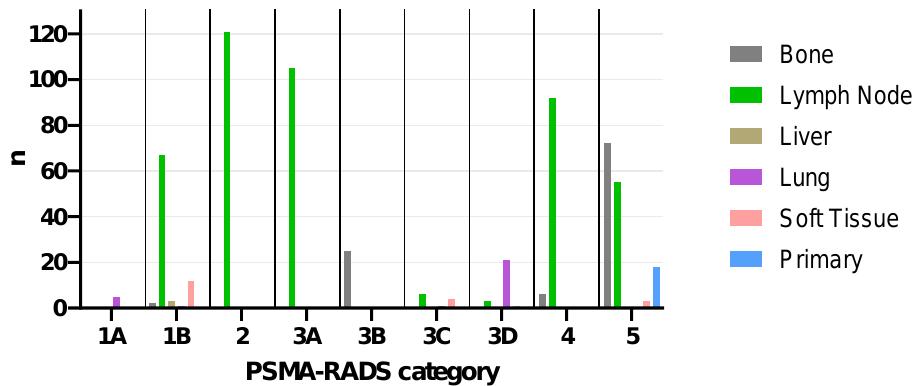
Figure 1. Bar graph showing the distribution of total lesions (n = 623) across all compartments and PSMA-RADS categories. Bone: 1B (n = 2), 3B (n = 25), 4 (n = 6), 5 (n = 72), total (n = 105); Lymph Node: 1B (n = 67), 2 (n = 121), 3A (n = 105), 3C (n = 6), 3D (n = 3), 4 (n = 92), 5 (n = 55), total (n = 449); Liver: 1B (n = 3), total (n = 3); Lung: 1A (n = 5), 1B (n = 1), 3C (n = 1), 3D (n = 21), total (n = 28); Soft Tissue: 1B (n = 12), 3C (n = 4), 3D (n = 1), 5 (n = 3), total (n = 20); Primary: 5 (n = 18), total (n = 18). PSMA-RADS = prostate-specific membrane antigen reporting and data